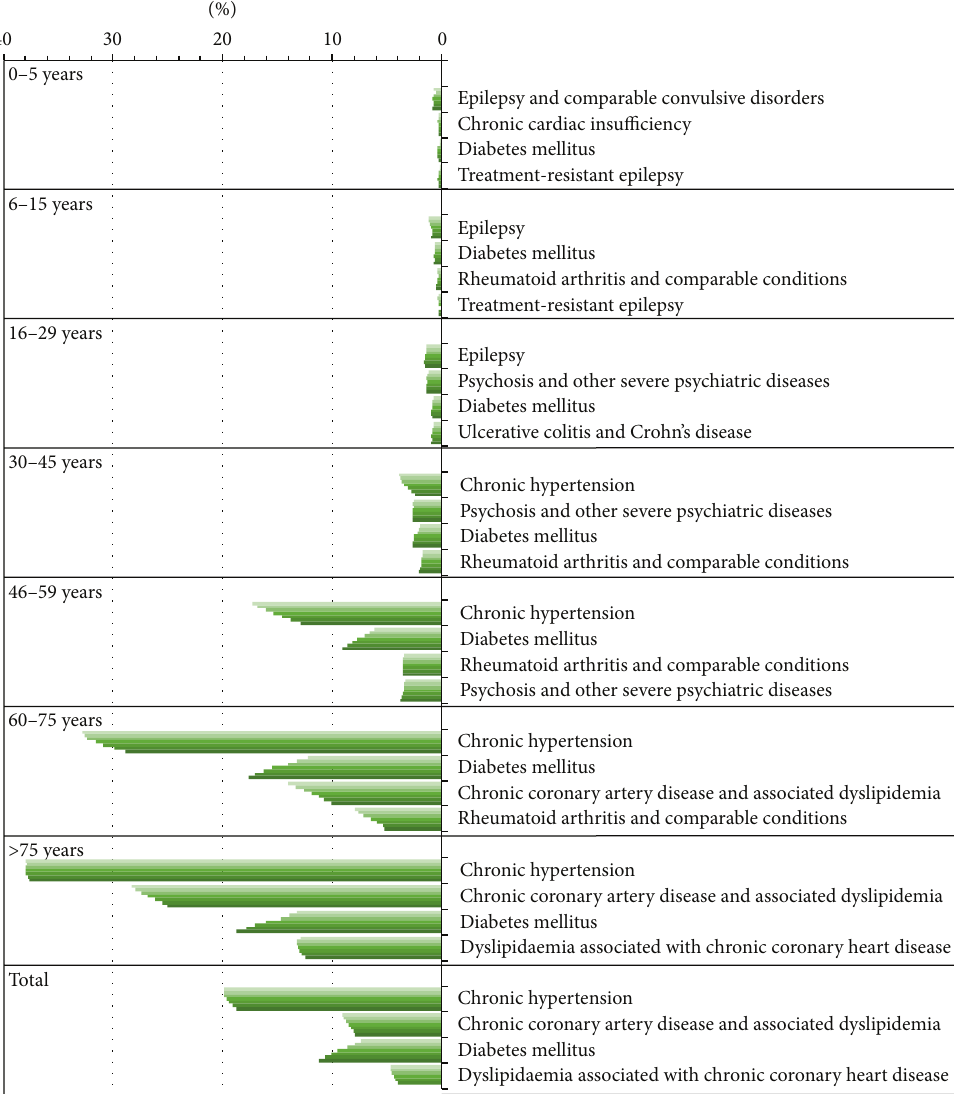
compared with the total population, also after Bonferroni correction for multiple